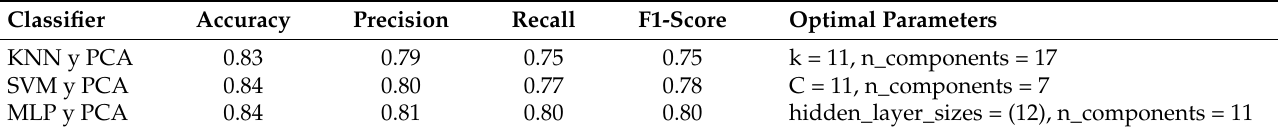
Table 10. Optimal parameters and precision results for each classifier on dataset2 .